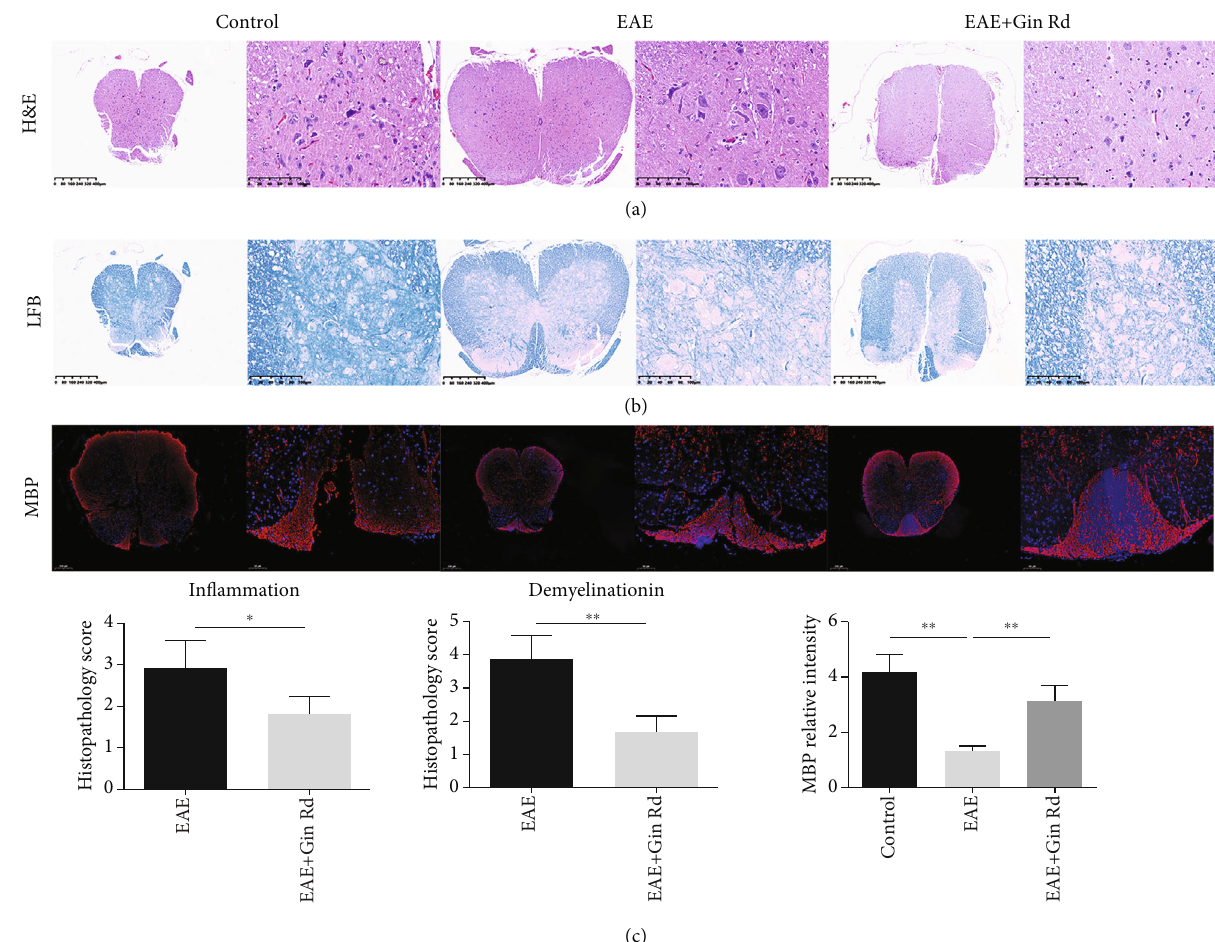
Figure 2: Ginsenoside Rd treatment ameliorated the severity of EAE via inhibiting spinal cord in fl ammation and demyelination. Following immunization and treatment with Ginsenoside Rd, some mice from the control, EAE, and Ginsenoside Rd-treated EAE groups were subjected to histopathological assay at day 20 postimmunization. Spinal cord tissue sections were stained with H&E or LBP, respectively. In addition, the degrees of in fl ammatory in fi ltrates and demyelination were semiquantitatively analyzed. Data are expressed as the mean ± SD for each group ( n = 3 ). (a) H&E analysis of the spinal cord sections. Magni fi cation × 40, 200. (b) LBP analysis of the spinal cord sections. Magni fi cation × 40, 200. (c) MBP immuno fl uorescence staining of the spinal cord sections. Tissue sections of spinal cord from each group mice were stained with antibodies against MBP (red) and DAPI (blue, nucleus). Magni fi cation × 50, 200. ∗ P < 0 : 05 , ∗∗ P < 0 : 01 vs. EAE group. Gin Rd: Ginsenoside